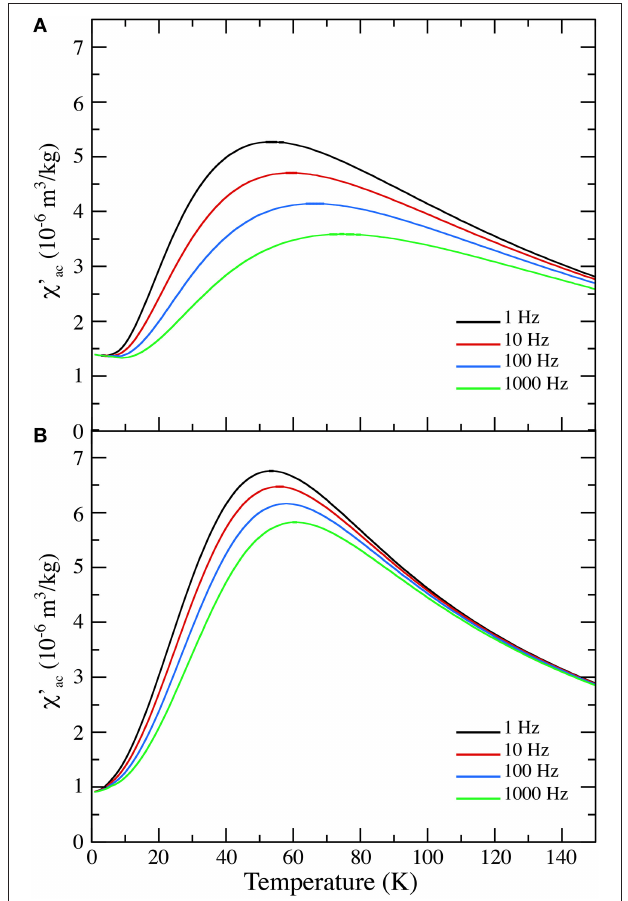
FIGURE 10 | Models of low-temperature alternative current ( ac ) magnetic susceptibility curves ( χ ′ ) for 3.4nm superparamagnetic particles with an effective anisotropy of 3.2 × 10 5 J/m 3 (A) and two component anisotropy with a volume anisotropy of 3 × 10 4 J/m 3 and a surface anisotropy of 5. 1 × 10 − 5 J/m 2 (at 10 K) (B).